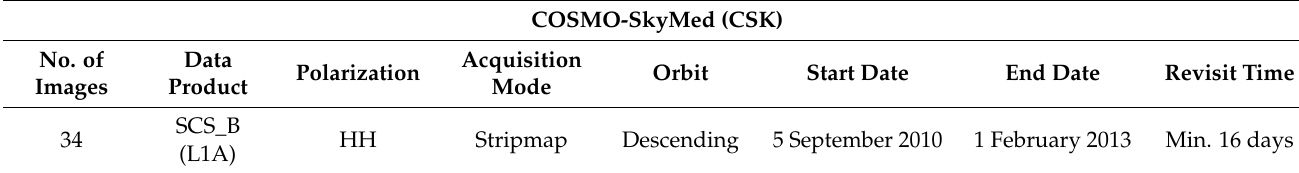
Table 1. Characteristics of the dataset.